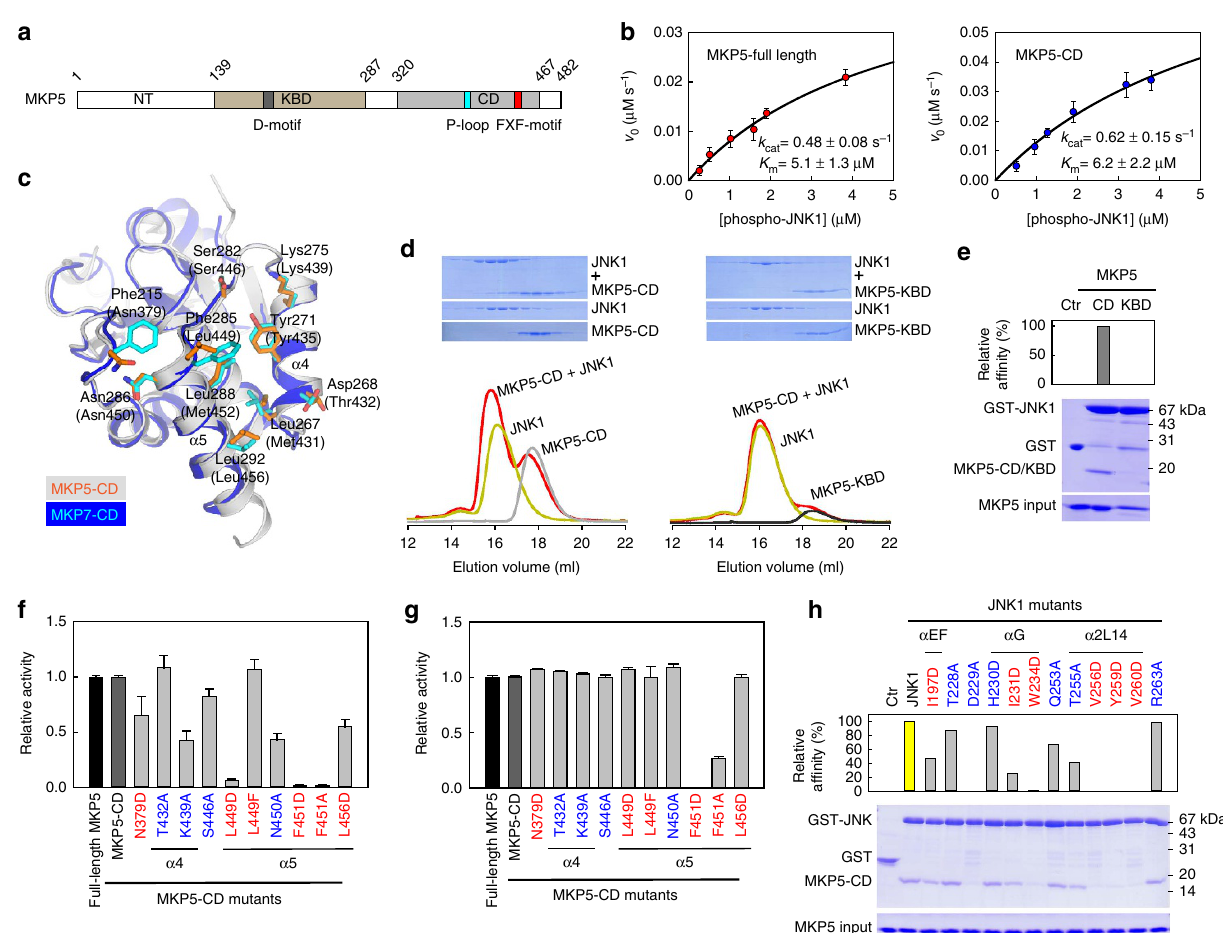
Figure 7 | MKP5-CD is crucial for JNK1 binding and enzyme catalysis. ( a ) Domain organization of human MKP5. The KBD and CD of MKP5 are shown in brown and grey, respectively. ( b ) Plots of initial velocity of the MKP5-catalysed reaction versus phospho-JNK1 concentration. The solid lines are best-fitting results according to the Michaelis–Menten equation with K m and k cat values indicated. Each experiment was performed in replicate for at least three times. The error bars represent s.e.m. ( c ) Structural comparison of the JNK-interacting residues on MKP5-CD (PDB 1ZZW) and MKP7-CD. The corresponding residues on MKP5 are depicted as orange sticks, and MKP5 residues numbers are in parentheses. ( d ) Gel filtration analysis for interaction of JNK1 with MKP5-CD and MKP5-KBD. ( e ) GST-mediated pull-down assays for interaction of JNK1 with MKP5-CD and MKP5-KBD. The panels are arranged the same as in Fig. 2d. ( f ) Effects of mutations in MKP5-CD on the JNK1 dephosphorylation (mean ± s.e.m., n ¼ 3). ( g ) Effects of mutations in MKP5-CD on the p NPP hydrolysis reaction (mean ± s.e.m., n ¼ 3). ( h ) Pull-down assays of MKP5-CD by GST-tagged JNK1 mutants. The panels are arranged the same as in Fig.